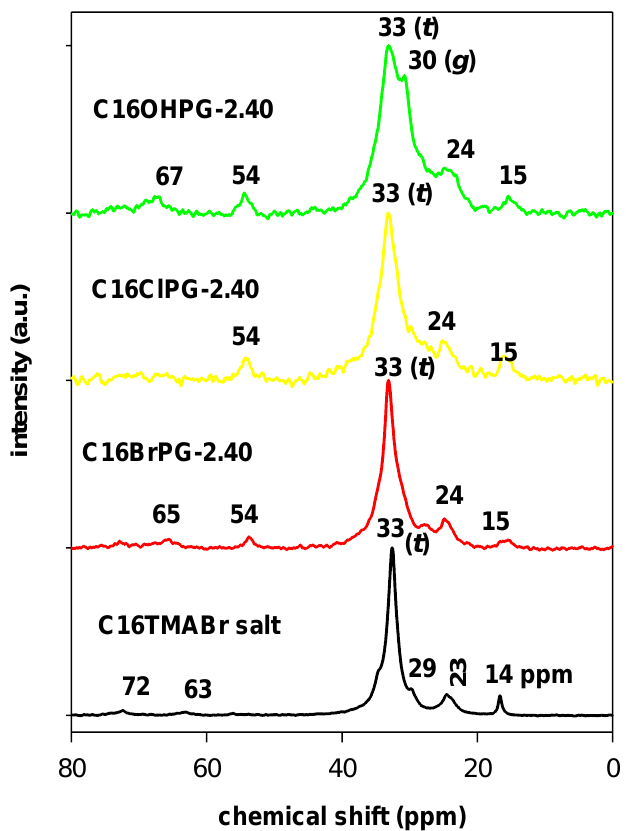
Figure 8. 13 C CP NMR spectrum of pure C16TMABr salt and the OCs prepared from different C16TMA solutions.